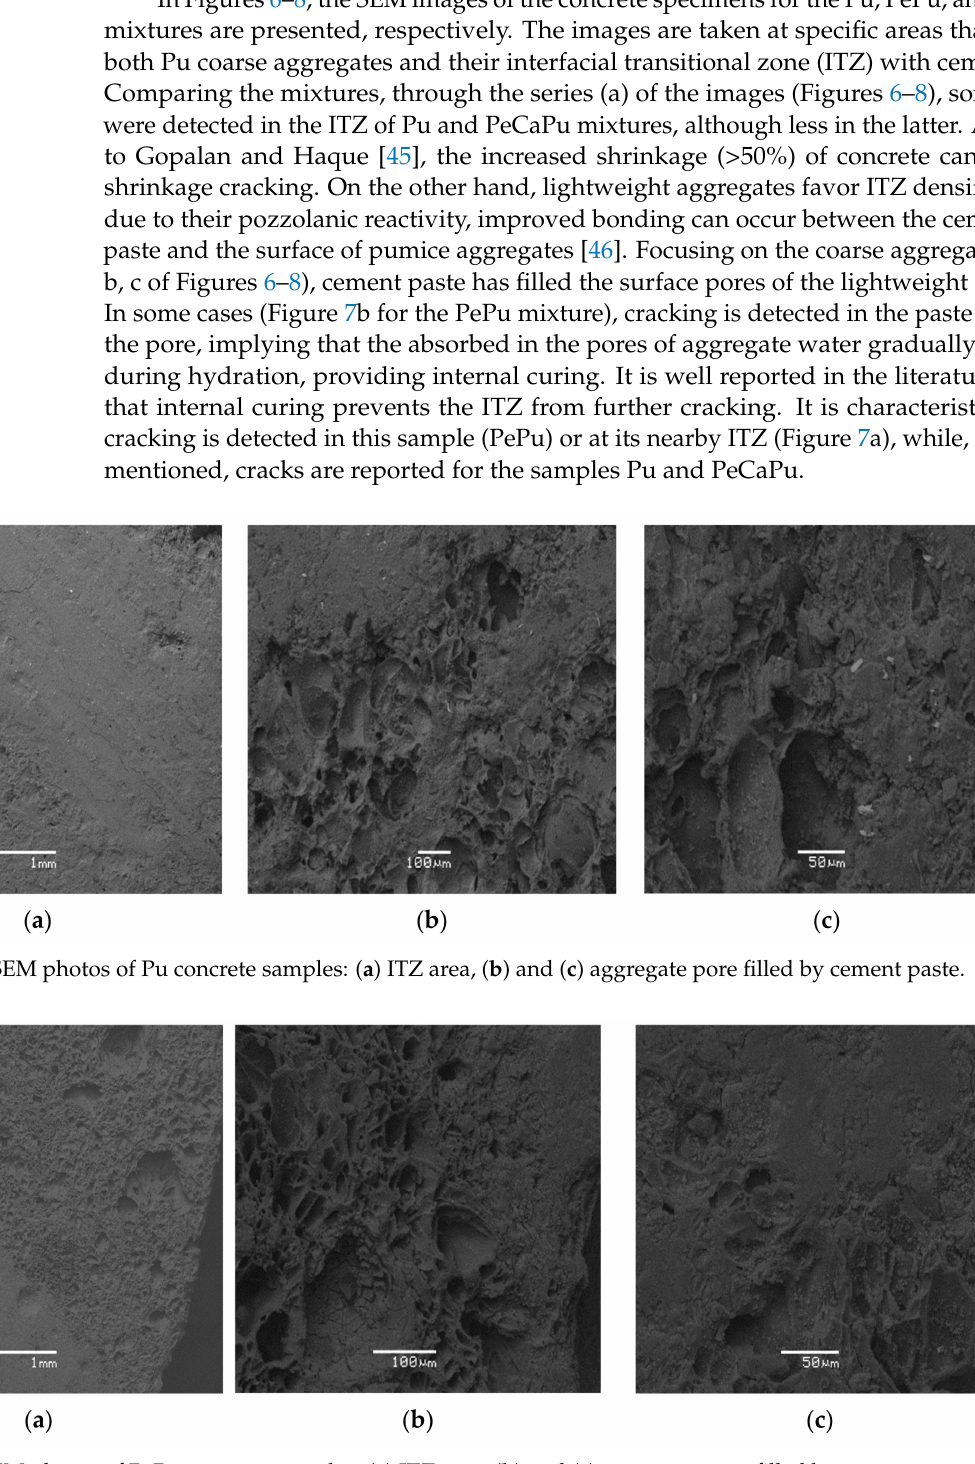
Figure 7. SEM photos of PePu concrete samples: ( a ) ITZ area, ( b ) and ( c ) aggregate pore filled by cement